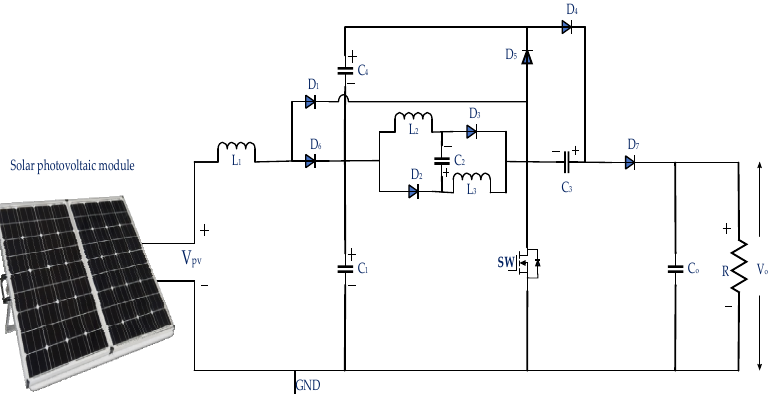
Figure 5. Proposed topology circuit with PV module configurations.